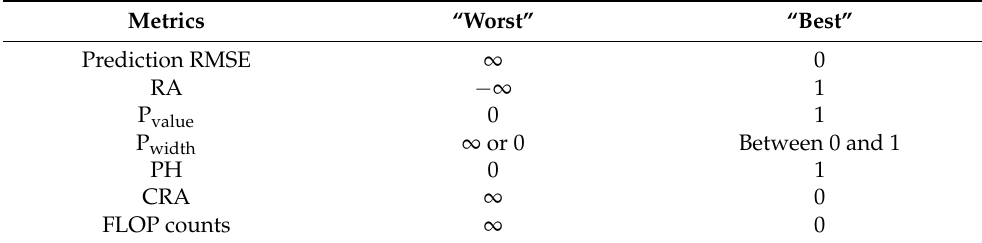
Table 4. Reference values of the unified set of metrics.